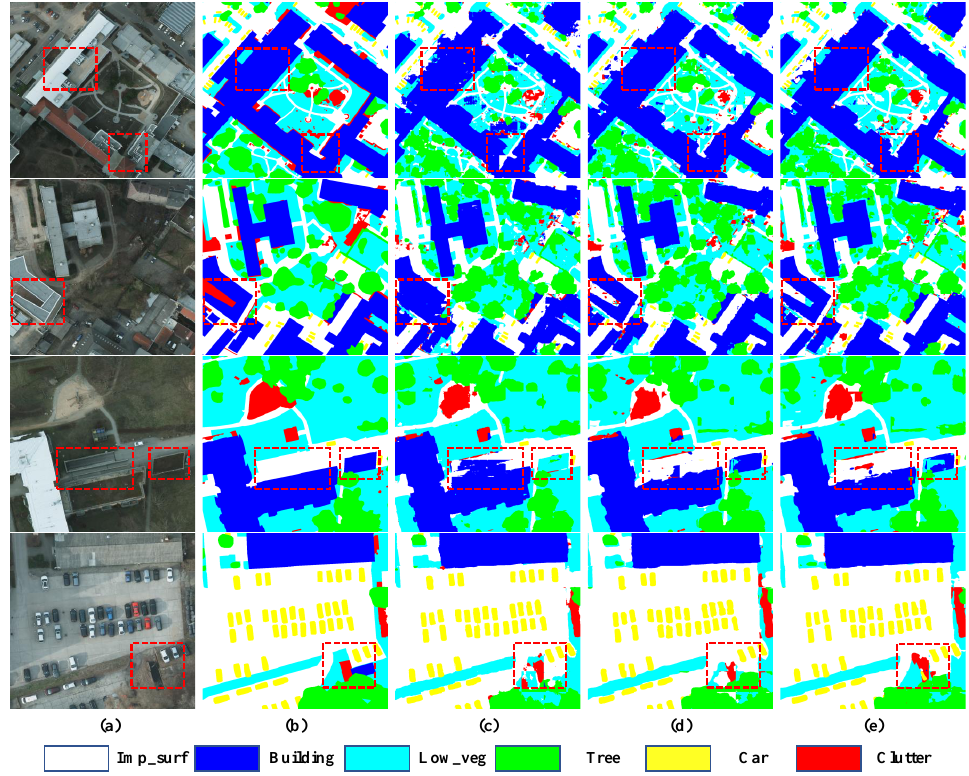
Figure 12. Slices from the prediction results. From left to right, they are the data for ( a ) original high-resolution remote sensing RGB slices, ( b ) the corresponding ground truth, ( c ) predictions of TdPFNet(RSI), ( d ) results fused with DSM and ( e ) results fused with OSM.